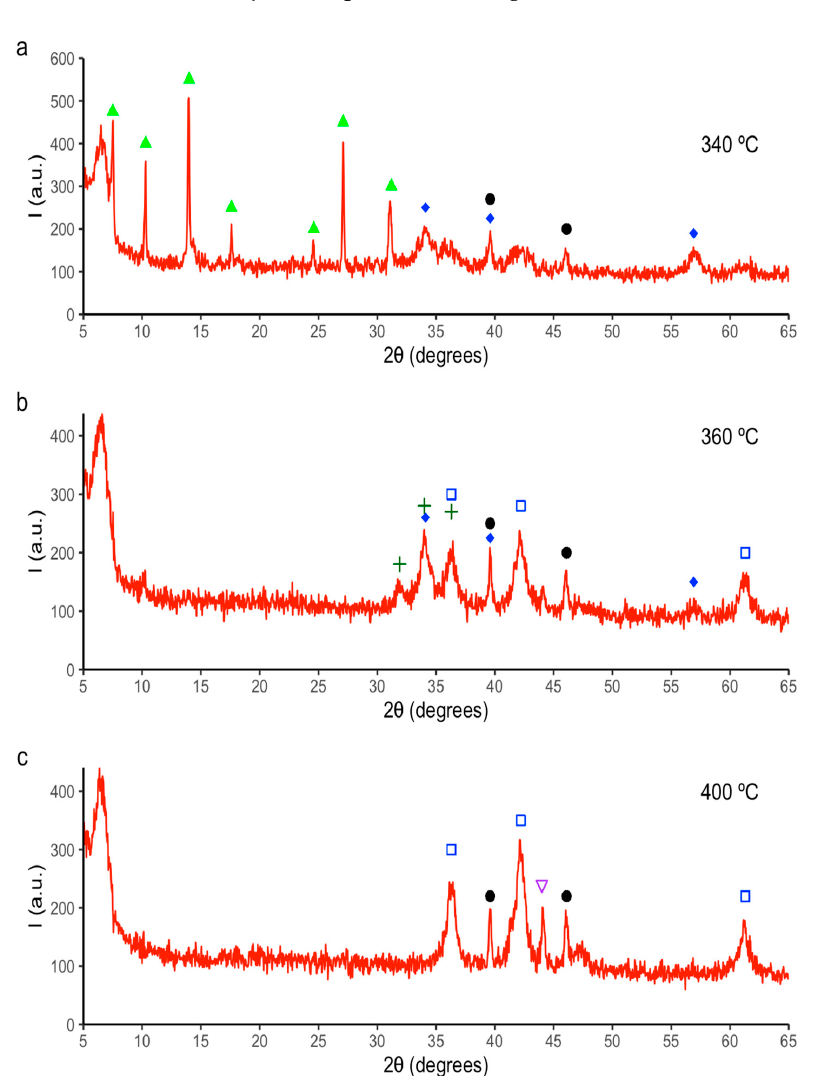
Figure 6. X-ray powder diffraction of cobalt (II) acetate tetrahydrate commercial sample heated under N 2 atmosphere at ( a ) 340 ◦ C, ( b ) 360 ◦ C, and ( c ) 400 ◦ C. Main peaks of identified phases are marked as follows: black circle for platinum (PDF-01-087-0642), green triangle for cobalt oxide acetate (PDF-00-022-0595), blue diamond for CoO Zn-Blende (PDF-00-042-1300), dark green cross for CoO Wurtzite (PDF-04-005-4913), blue square for CoO rocksalt (PDF 00-048-1719), and purple inverted triangle for Co (PDF-01-089-4308).